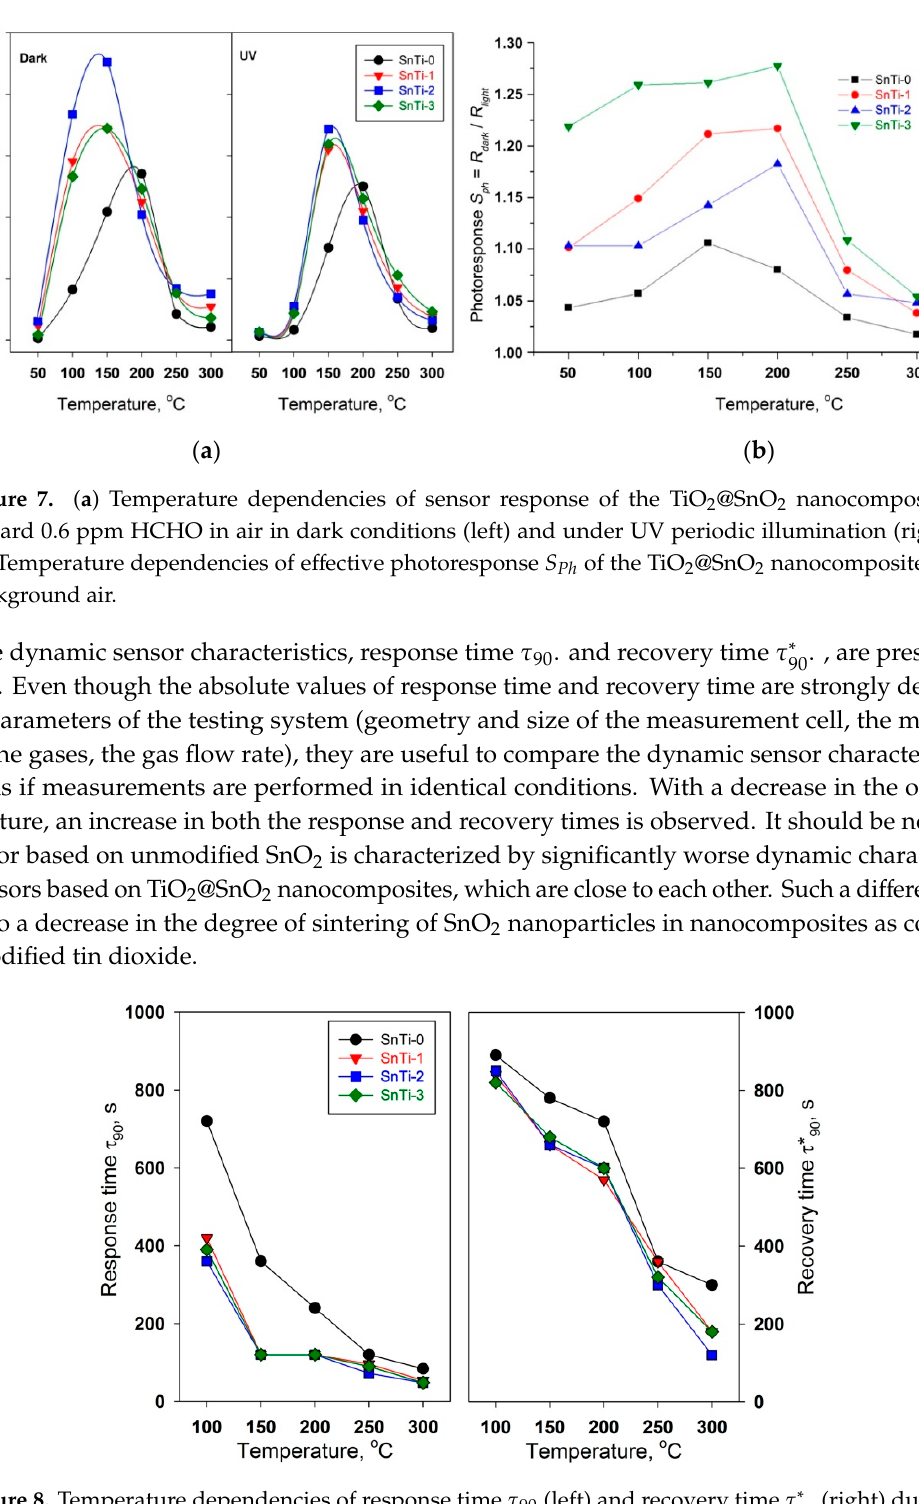
(right) during 90